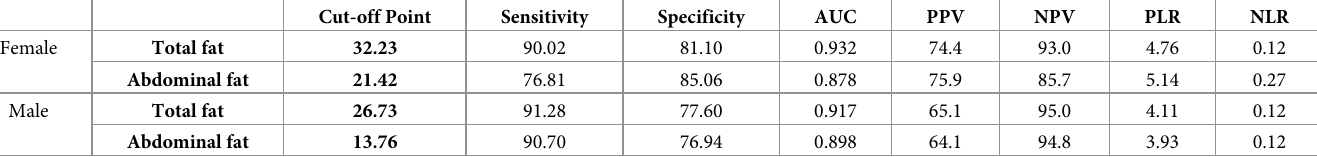
Table 4. Receiver operating characteristic curve (ROC) analysis for defining the ideal fat percentage of body weight cut-off point based on nonalcoholic fatty liver disease. Cut-off Point Sensitivity